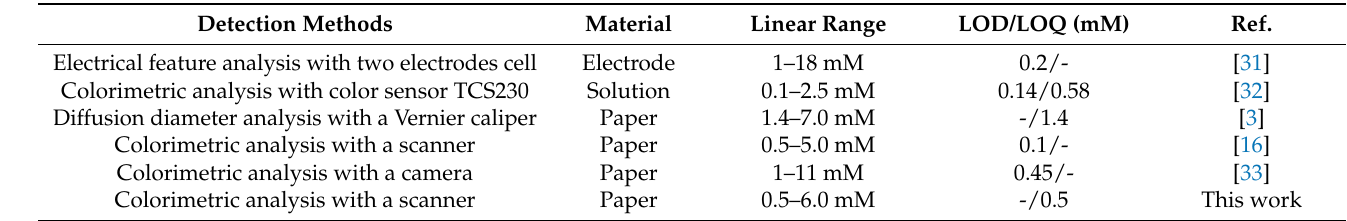
Table 2. Determination of glucose using paper device and compared the results with other re- ported methods.